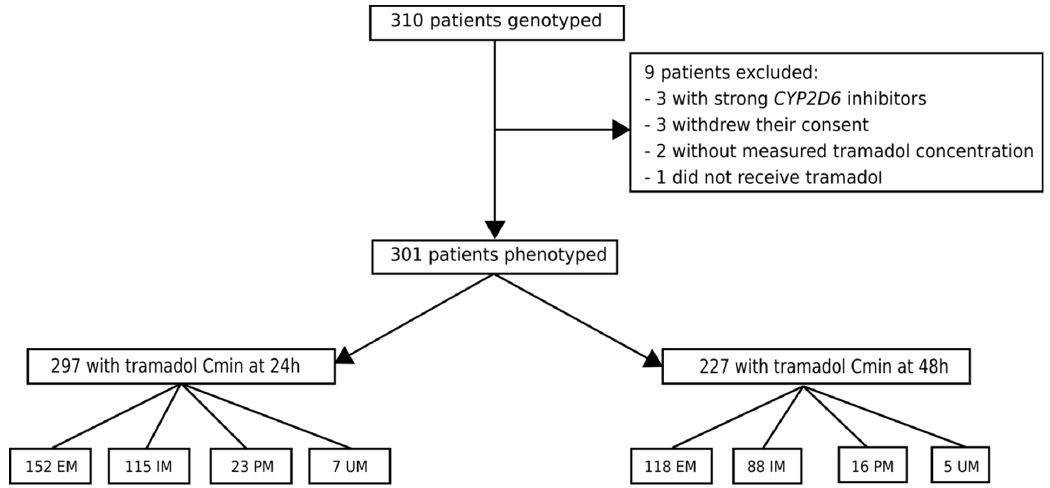
Figure 1. Flowchart of data analysis.